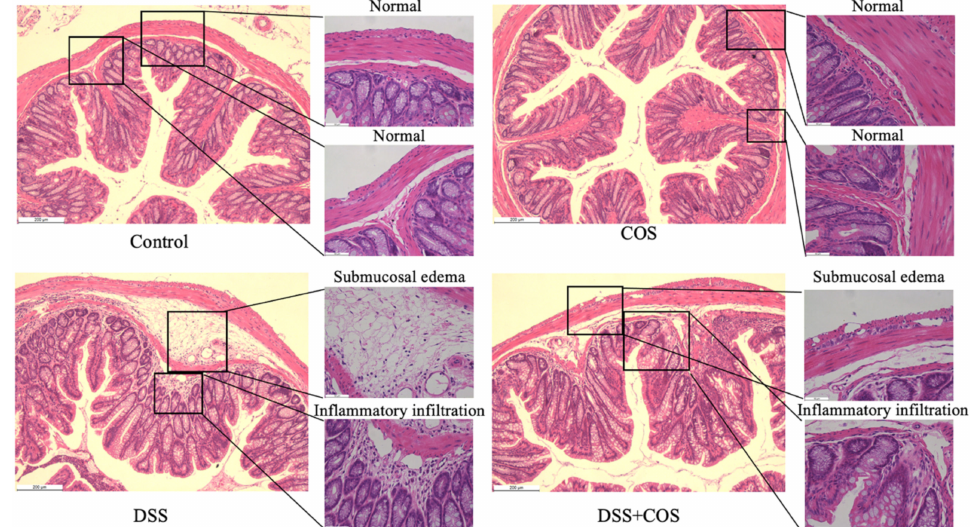
Figure 6. Effect of treatment with COS on histopathological alteration in DSS-induced colitis. Mice were given 4% (wt/vol) of DSS in drinking water for 7 consecutive days and intraperitoneally injected with COS at a dose of 200 mg/kg/day for 21 days at the same time. The histological changes of the colon in the control, COS, DSS, and DSS + COS groups were imaged by H&E (hematoxylin and eosin) staining. Black frames indicate normal structure, submucosal edema, and the infiltration of inflammatory cells. Scale bars, 200 µ m and 50 µ